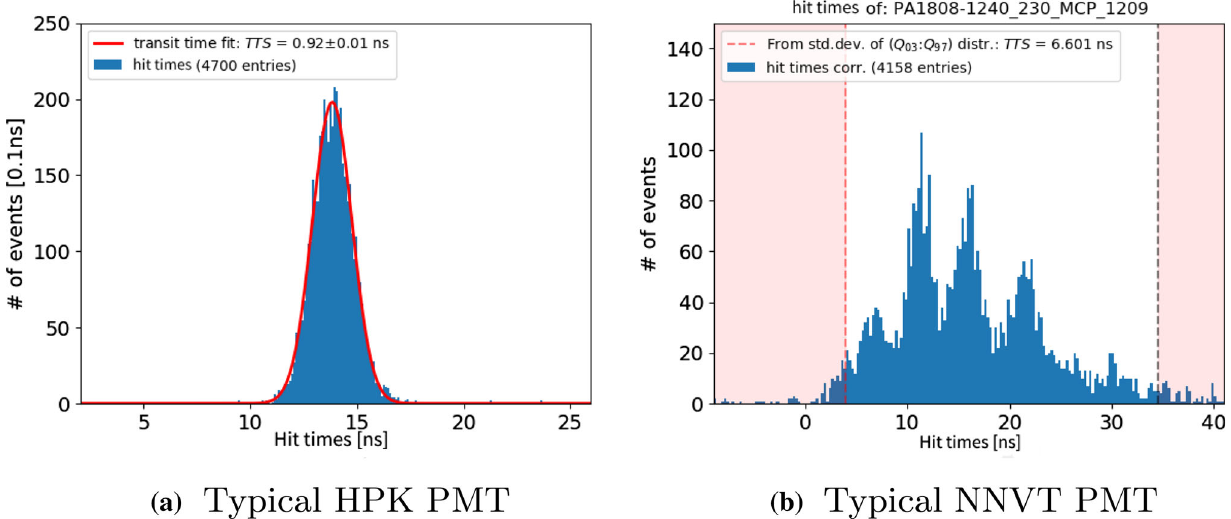
Fig. 25 Typical relative transit time (TT) distributions for an HPK (left) and an NNVT PMT (right, indicated “hit times”). The PMT’s TTS is determined using a Gaussian fit in case of the HPK PMTs, and